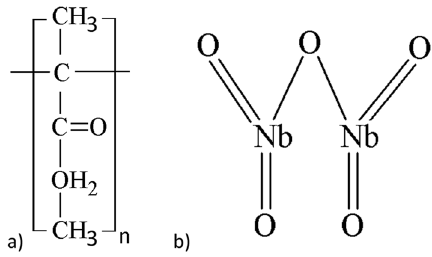
Figure 1. Chemical structures of PMMA ( a ) and Nb 2 O 5 ( b ).